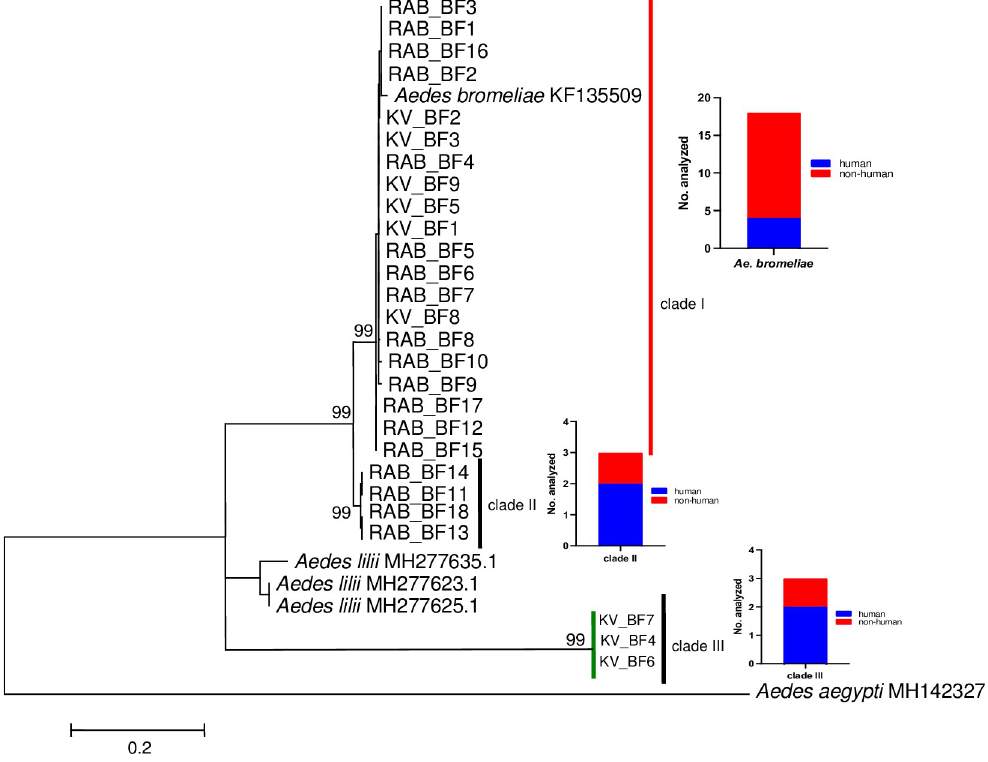
Fig 4. Maximum-likelihood tree derived from Aedes simpsoni blood-fed ITS2 sequences using a JC model (255–313 nt). Bootstrap values are shown above relevant nodes. Sequence of Ae . aegypti indicated as outgroup. The scale-bar indicates the number of substitutions per site. Taxon abbreviations represent sampling sites with numbers corresponding to specific sequence samples: RAB, Rabai; KV, Kerio Valley. Sequences have been submitted to GenBank with accession numbers OK339453–OK339472 ( Aedes bromeliae ), OK339473-OK339479 ( Aedes simpsoni sl).